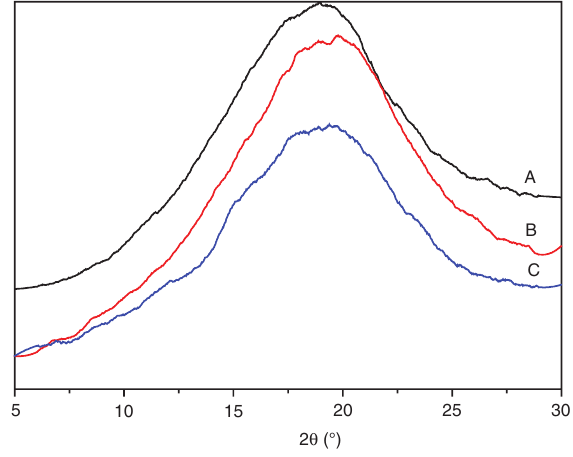
Figure 11: XRD patterns of SPUA0 (A), SPUA4 (B), and SPUA8 (C).